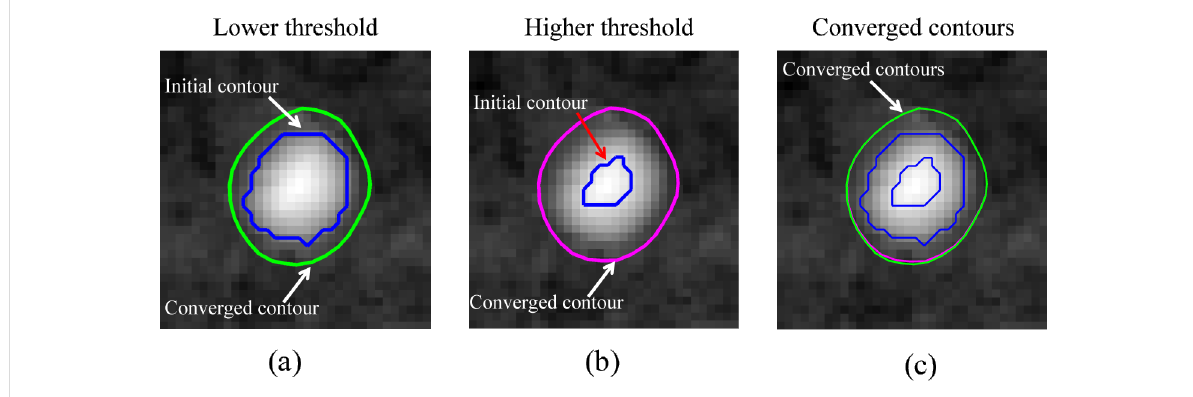
Figure 7: The proposed method is robust to the selection of the threshold value during contour initialization. (a) Initialized contour obtained with a lower threshold value (10 nm) and corresponding converged contour obtained using the proposed method. (b) Initialized contour obtained with a higher threshold value (18 nm) and corresponding converged contour. (c) Comparison of the initialized contours and the converged contours obtained with the different threshold values. The coverged contours are superimposed on each other, which indicates that the proposed method is robust to the selection of the threhold value.